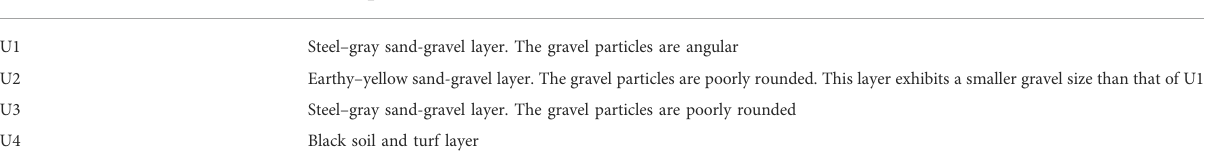
TABLE 4 Unit description of exposure XD.